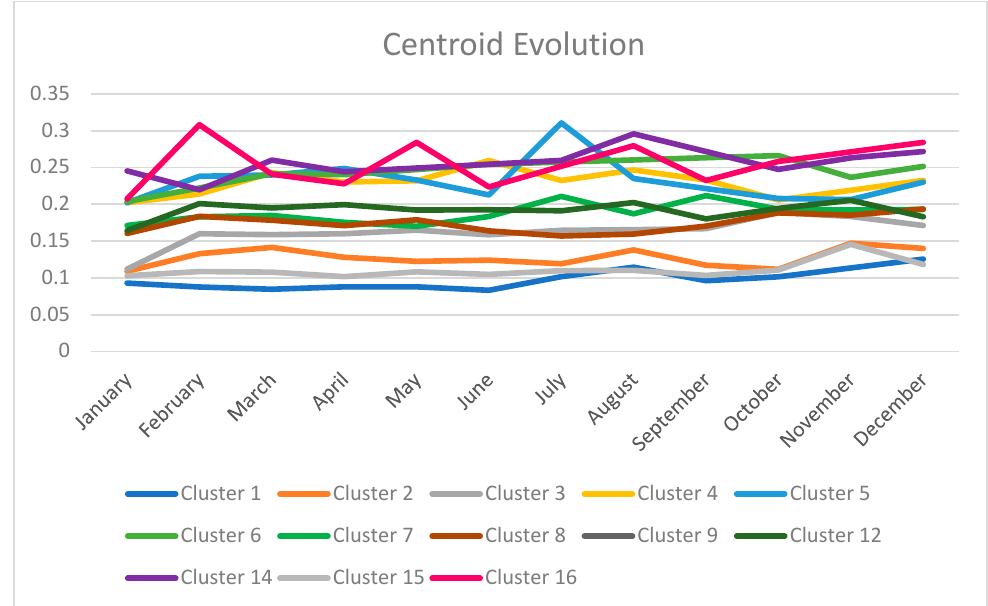
Figure 4. Evolution of the centroid of the first groups with LAMDA.